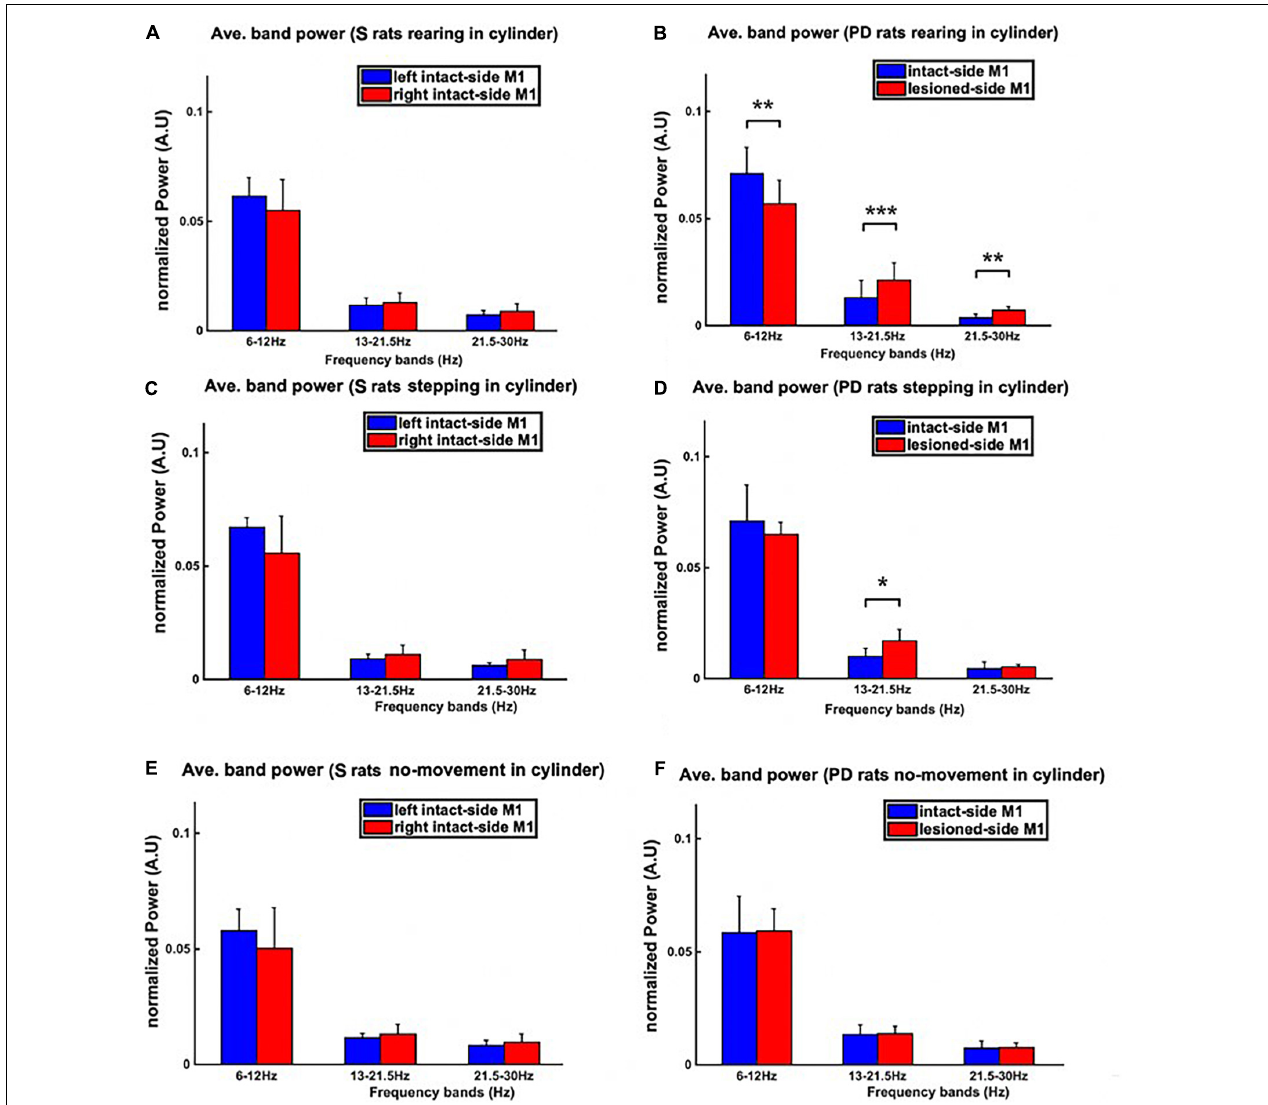
FIGURE 9 | The power spectral density (PSD) during the three behavioral patterns of the cylinder test (i.e., rearing, stepping, and no-movement) was analyzed. The PSD was averaged over theta, low beta, and high beta bands measured from both hemispheres, resulting in three bins, one for each band. The averaged-PSD comparison of the right vs. left M1 of sham rats is shown in the left column (A,C,E) , whilst the same comparison for PD rats is shown in the right column (B,D,F) . (B) During rearing in PD rats, both the low and high beta power from the lesioned hemisphere (right hemisphere) is significantly higher than in the intact hemisphere. (D) During stepping episodes, however, only the power in the low beta band is significantly higher in the lesioned than in the intact hemisphere. (F) No significant differences between hemispheres can be observed for any band during inactive episodes in PD rats. (A,C,E) Similarly, no significant differences are found by comparing the power in PD animals to that of sham group animals for inactive episodes. Level of significance: (* p < 0.05, ** p < 0.01, and *** p < 0.001). Figure adapted from Mottaghi